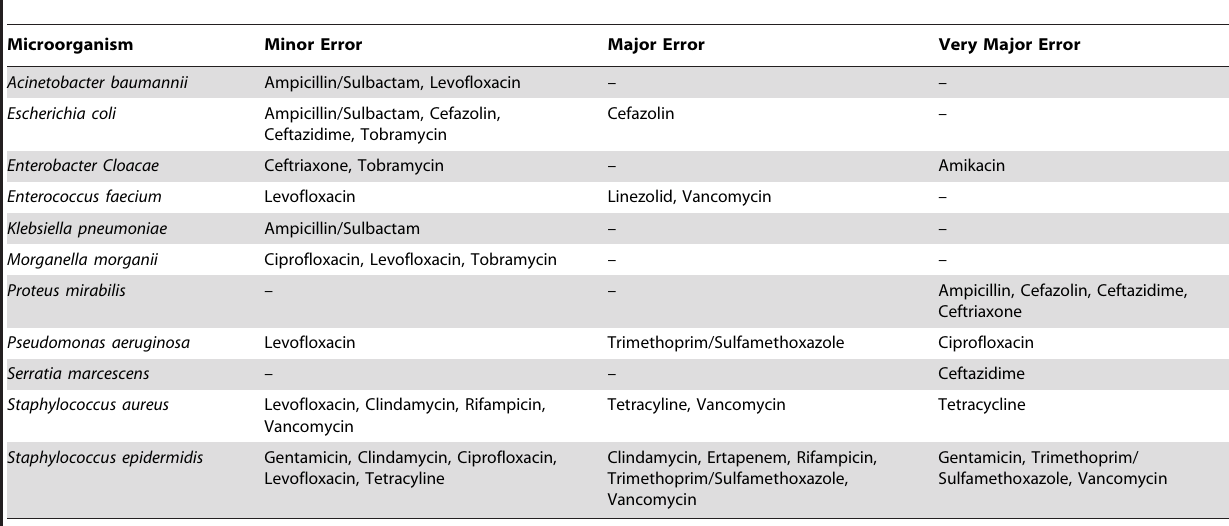
Table 2. Microorganism-antimicrobial combinations that did not result in agreement with conventional methods a